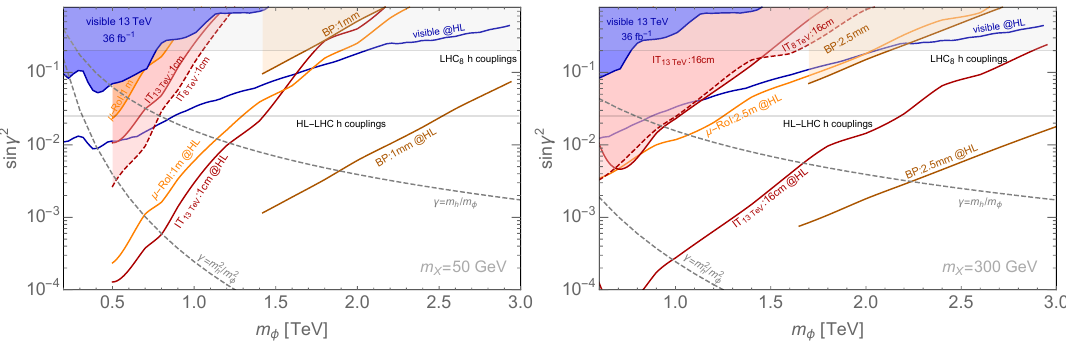
Figure 4 . Parameter space of the singlet Higgs as a function of m (cid:30) and sin 2 (cid:13) overlaid with current and projected constraints from direct searches, as well as current and projected indirect limits from coupling measurements of the Standard Model-like Higgs at 125 GeV. We choose m X = 50 GeV in the left panel, and m X = 300 GeV in the right panel. The blue shaded region is excluded by p the combination of current searches for decays in the ZZ and hh (cid:12)nal states at s = 13 TeV, while the blue line indicates the projected reach in the same channels for the HL-LHC. The grey shaded region is excluded by the combination of ATLAS and CMS Higgs coupling measurements p at s = 7 & 8 TeV, while the grey line indicates projections for the corresponding reach at the HL-LHC. The two grey dashed lines indicate natural parametric scalings of the mixing angle (cid:13) with the mass of the singlet Higgs ( (cid:13) = m h =m (cid:30) and (cid:13) = m 2 =m 2 ). For the displaced decays we assume h (cid:30) BR displaced ’ BR (cid:30) ! ZZ = 1 = 8. The red shaded region indicates the exclusion of the CMS inner p tracker (IT) search at s = 13 TeV assuming c(cid:28) X = 1 cm on the left panel and c(cid:28) X = 16 cm on the p right panel, the dashed red line indicates the projection of the previous IT search at s = 8 TeV for the same lifetimes. The red line is the HL-LHC reach assuming zero background and same p lifetimes. The orange shaded region is excluded by the CMS beampipe (BP) search at s = 13 TeV for c(cid:28) X = 1 mm on the left panel and c(cid:28) X = 2 : 5 mm on the right panel. The orange line indicates the projected reaches for the HL-LHC assuming zero background and same lifetimes. The orange shaded p region on the left panel indicates the exclusion of the ATLAS muon RoI search at s = 13 TeV for c(cid:28) X = 1 m while on the right panel the exclusion region for c(cid:28) X = 2 : 5 m is already covered by the visible search. The orange lines are the projected reaches for the HL-LHC assuming zero background and same